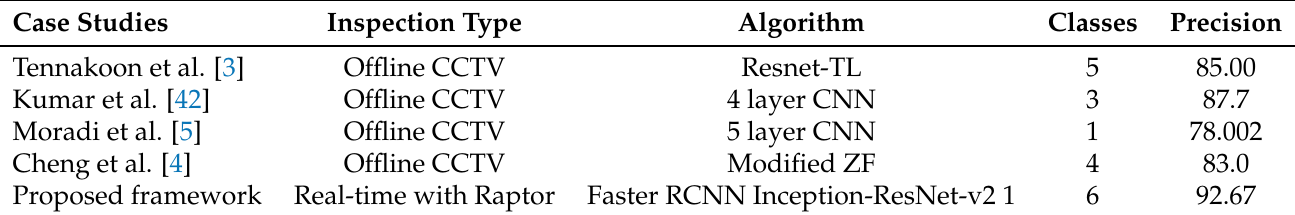
Table 6. Comparison analysis with existing object detection frameworks.